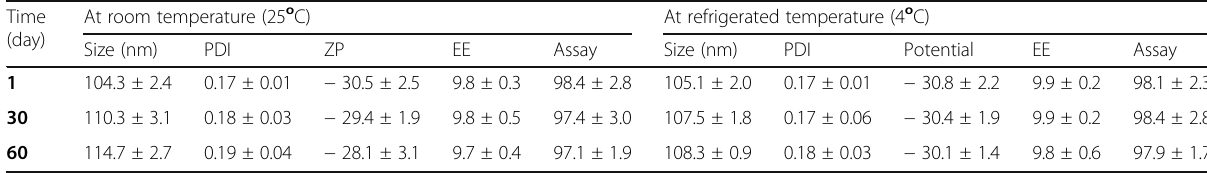
Table 4 Stability studies of optimized formulation of ZT-SLN (F1) at both room temperature (25 °C) and refrigerated (4 °C) for a period 2 months (mean ± SD, n = 3) Time At room temperature (25 o C) At refrigerated temperature (4 o (day)